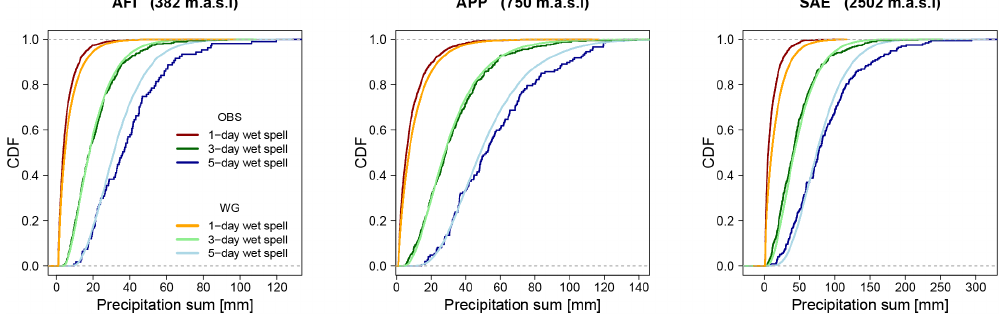
Figure 6. Cumulative distribution functions (CDFs) of multi-day precipitation sums for the three stations Andelfingen (AFI), Appenzell (APP) and Saentis (SAE). The lines represent the CDFs of non-zero precipitation amounts over 1 day (red), over 3 consecutive wet days (green) and over 5 consecutive wet days (blue). Darker and lighter colours refer to observations and simulations, respectively. The observed CDFs have been derived from a 51-year long daily time series between 1961 and 2011, those of the weather generator from 100 realisations of 51-year long daily simulations. Note that the scaling of the horizontal axis differs between different